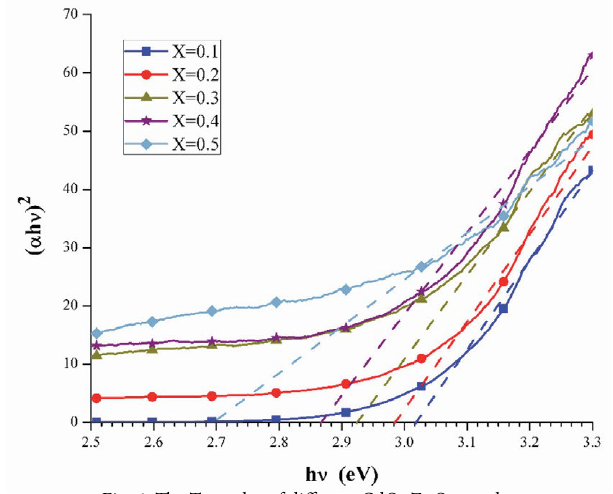
Fig. 4. The Tauc plot of different CdO–ZnO samples Fig. 4TheTaucplotofdifferentCdO–ZnOsamples Table 2. The average crystal size, band gap energy (E ) and reaction rate constants (k) of MO g photodegradation for different Cd